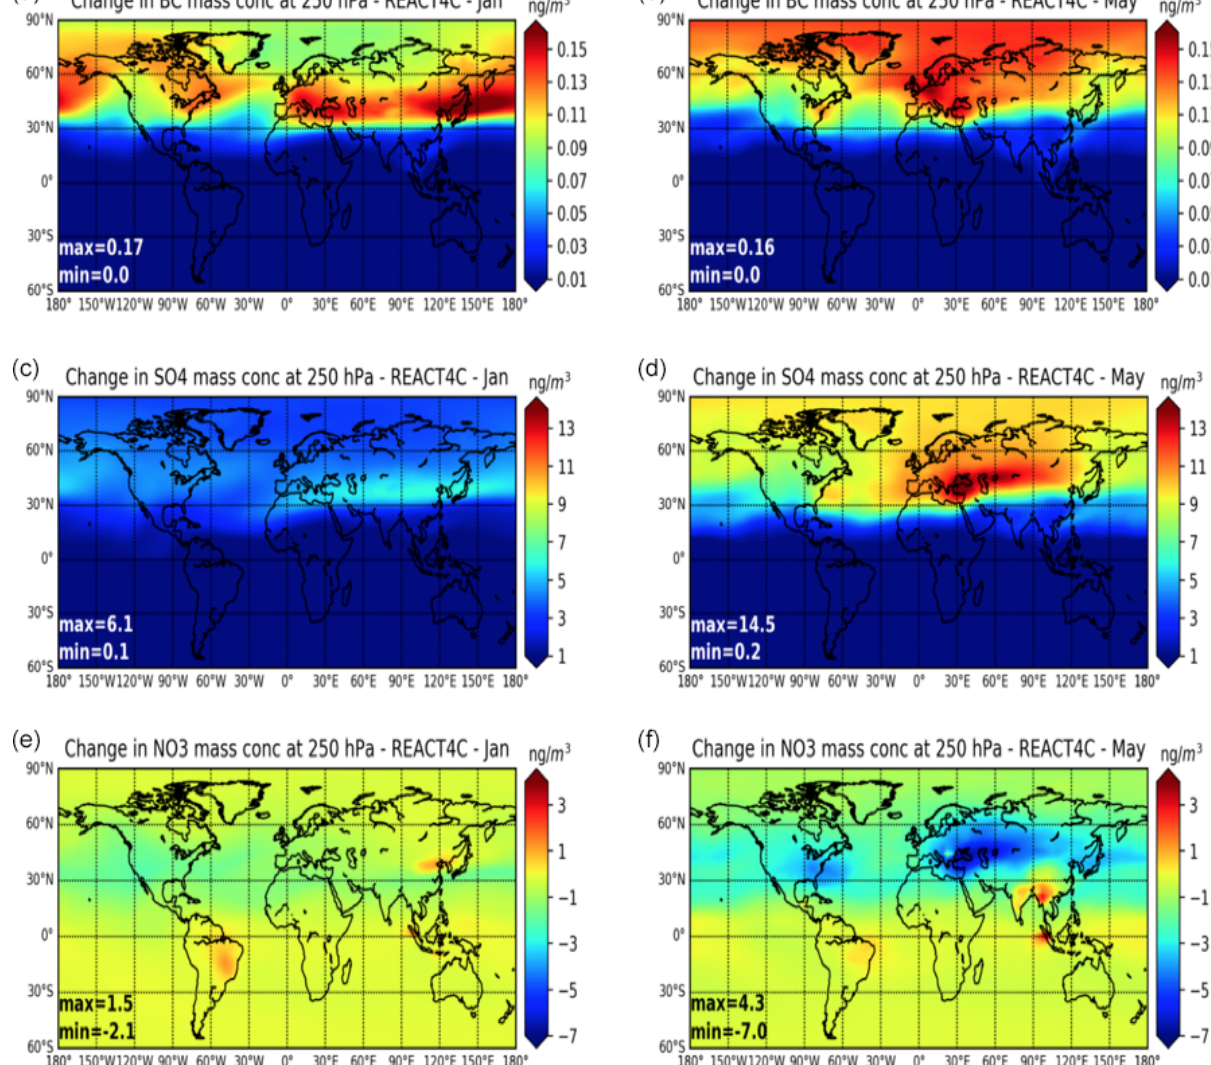
Figure 6. Spatial distributions of the 250hPa perturbations due to aircraft emissions for January (a, c, e) and May (b, d, f) for BC, SO 4 , and NO 3 (ngm − 3 ) for the REACT4C_2006